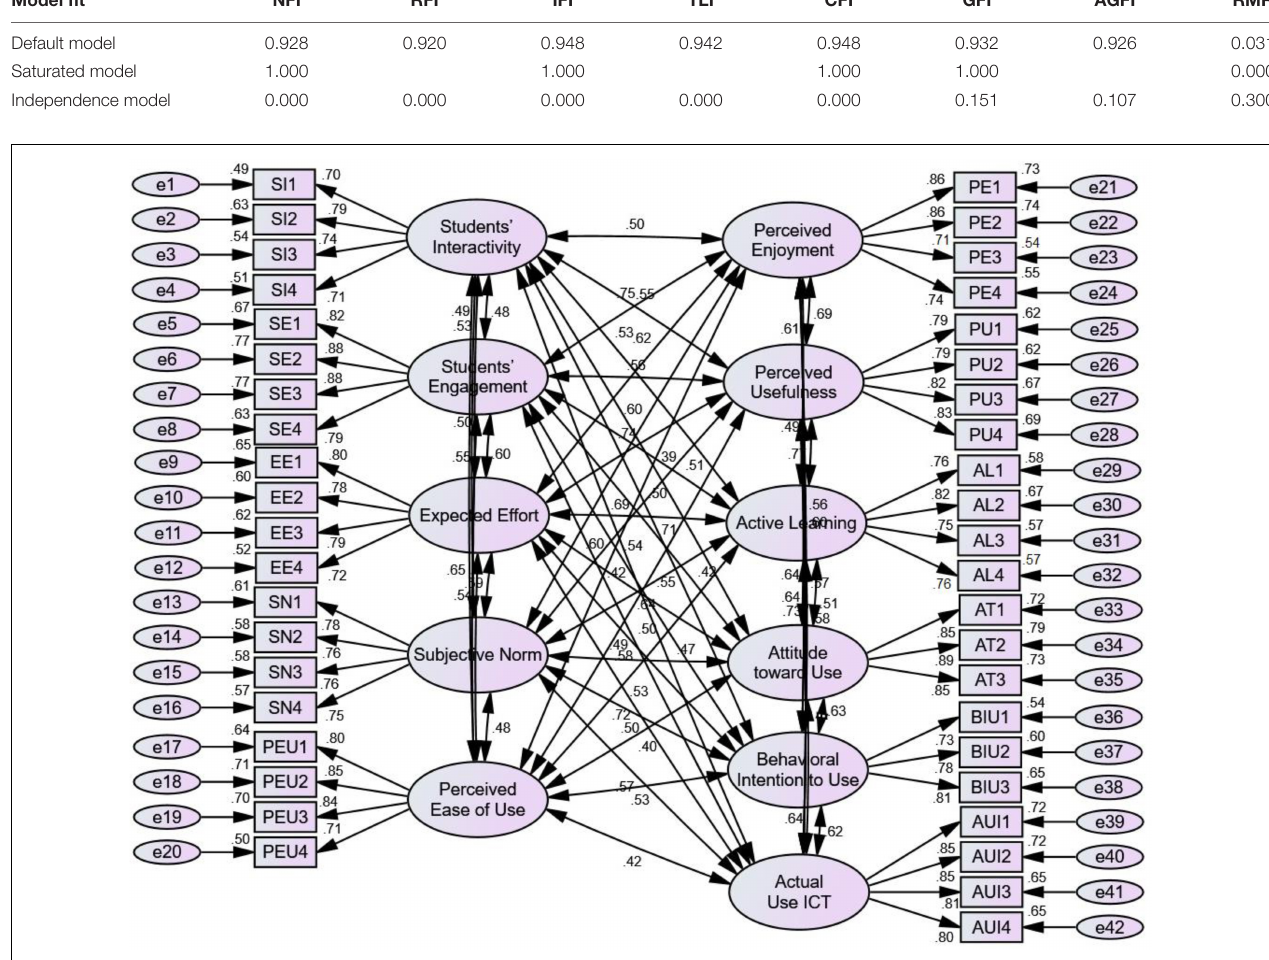
FIGURE 2 | Measurement